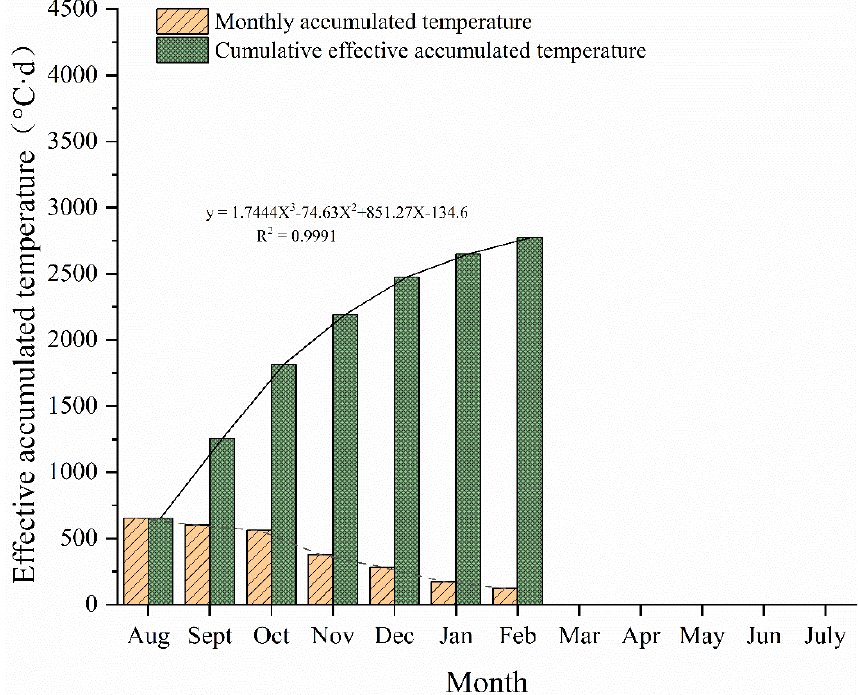
Figure 7. Monthly variation in effective accumulated temperature.